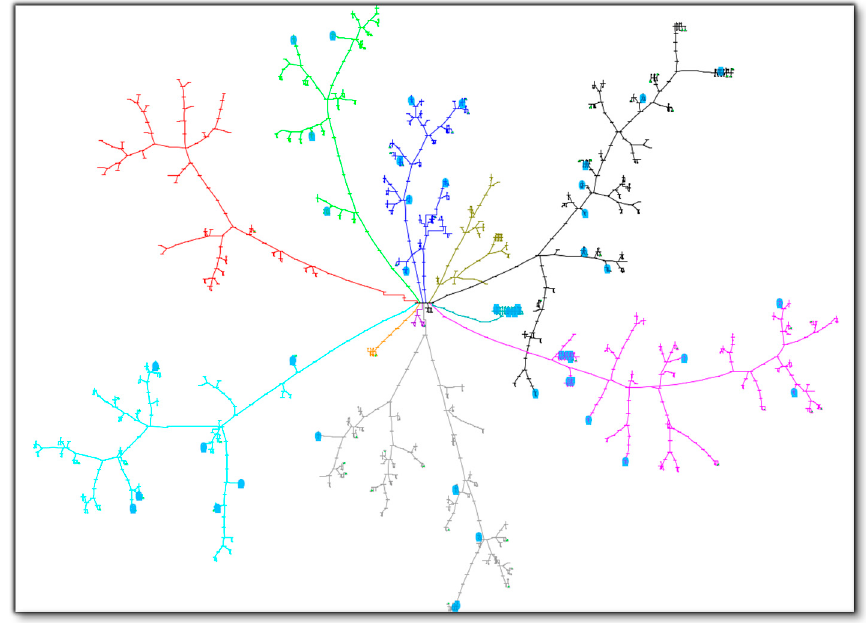
Figure A10. Use case 7—Location of PVs.